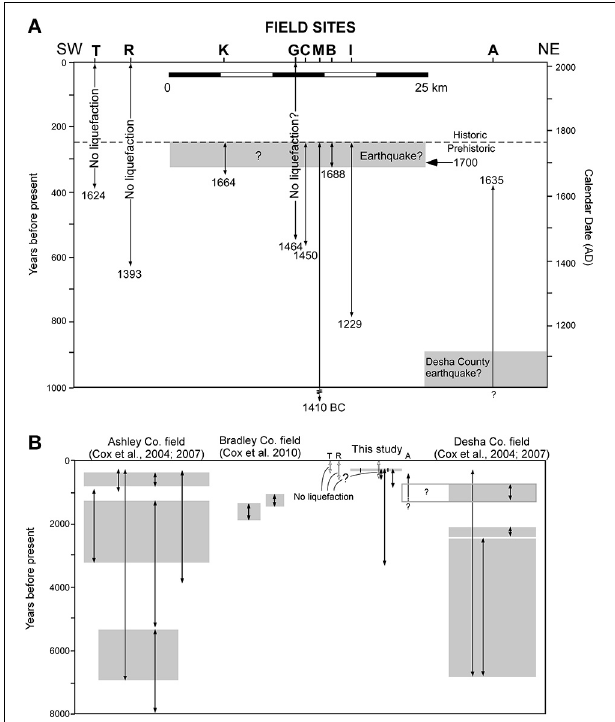
FIGURE 12 | (A) Time chart showing age ranges (vertical lines) for the generation of the liquefaction features as constrained by radiocarbon dates and historic records at 7 sites. The locations of field sites that display liquefaction were projected perpendicularly to a NE-SW-trending transect. The beginning of the historic period is placed at ∼ AD 1750 (Hanson and Moneyhon, 1989). Shading denotes possible correlations of liquefaction features at field sites to paleo-earthquakes. (B) Time chart showing age ranges for liquefaction events in adjacent sand blow fields. Gray shading denotes the time range in which a paleo-earthquake may have